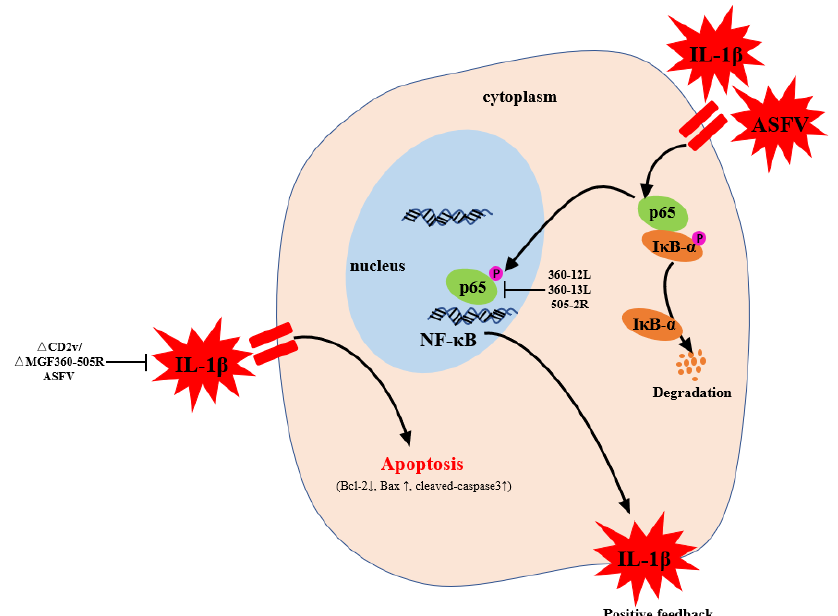
Figure 7. The mechanism of Δ CD2v/ Δ MGF360-505R-ASFV inhibits apoptosis after infecting PAMs cells. After infection with PAMs, GZ201801-ASFV promotes the release of IL-1 β to induce cell apoptosis. After Δ CD2v/ Δ MGF360-505R-ASFV infection with PAMs, the activation of NF- κ B pathway and IL-1 β are significantly lower than GZ201801-ASFV. Therefore, the percentage of apoptosis induced by Δ CD2v/ Δ MGF360-505R-ASFV infecting PAMs was significantly lower than in GZ201801-ASFV. Supplementary Materials: The following are available online at https://www.mdpi.com/article/10.3390/vaccines9111371/s1, Figure S1: Western blotting was used to detect the expression of p30 protein, Figure S2: Detection of PAMs cell purity, Figure S3: NF- κ B signaling pathway analysis after ASFV infection, Figure S4: Construct MGF360-505R plasmids, Figure S5: All of these plasmids were successfully expressed in PK-15 cells.